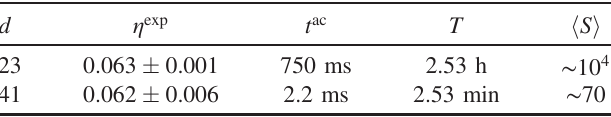
TABLE I. Experimental measurement time T required for a steering violation in two different dimensions d